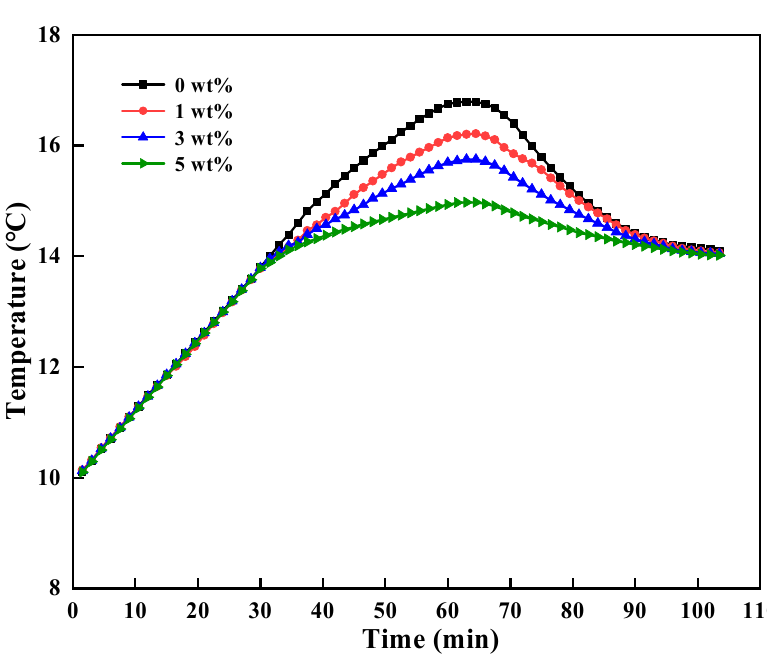
Figure 11. Temperature–time curves of different microcapsule solutions.